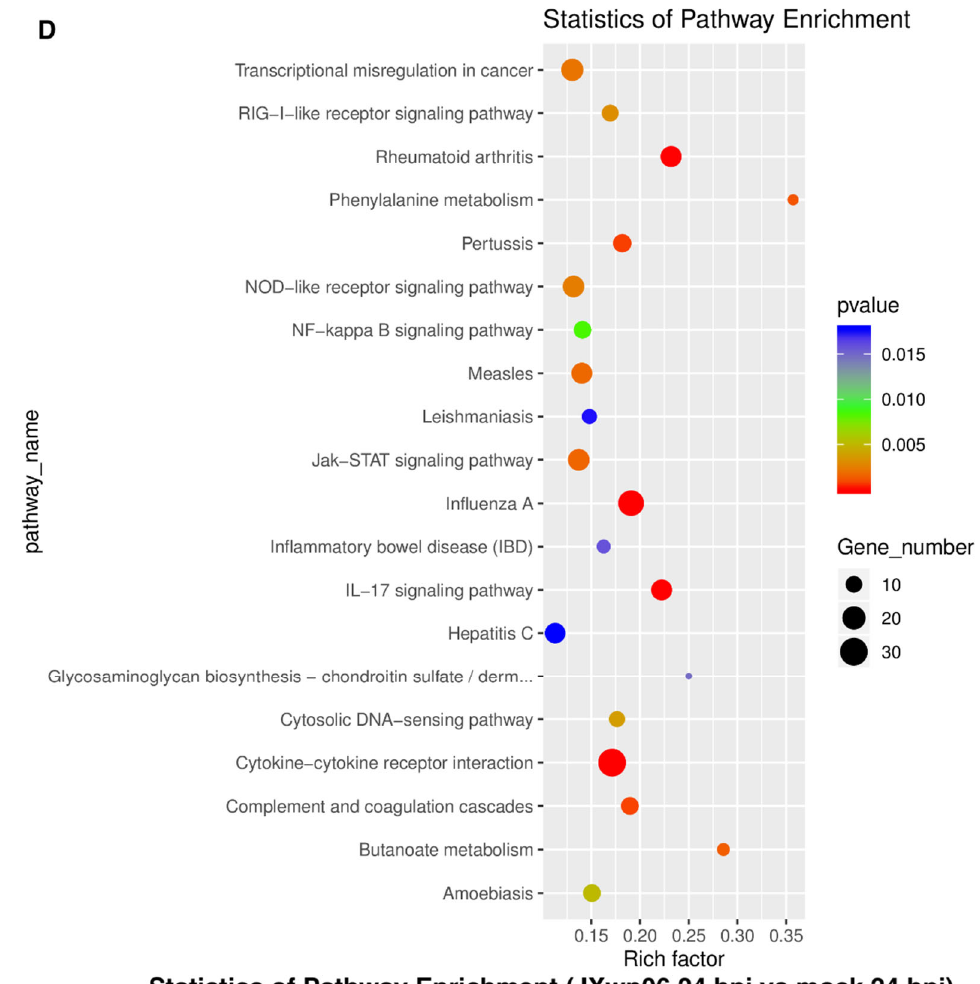
Figure 3. Gene Ontology (GO) terms and KEGG pathway enrichment of the DEGs. ( A , B ) The most significant enriched GO terms (top 50) among the DEGs in the JXwn06 inoculation group at 18 hpi vs. mock 18 hpi ( A ) and JXwn06 inoculation group at 24 hpi vs. mock 24 hpi ( B ). ( C , D ) The most significant enriched KEGG pathways among the DEGs in the JXwn06 inoculation group at 18 hpi vs. mock 18 hpi ( C ) and JXwn06 inoculation group at 24 hpi vs. mock 24 hpi ( D ).